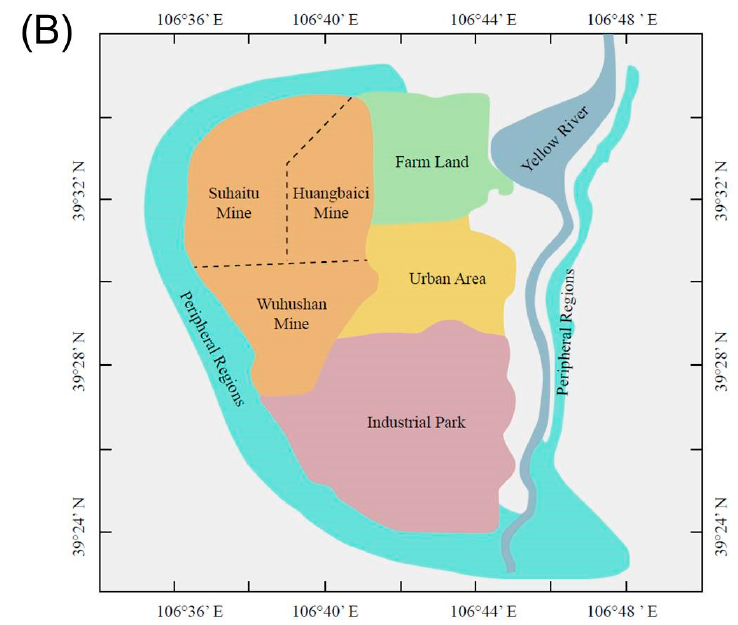
Figure 1. Location of Ordos Basin and the Wuda Coalfield and paleogeographic map of the Late Paleozoic in Northern China (modified after Han and Yang [33]; Liu [34]; and Dai et al. [35]) (1, Wuda Coalfield; 2, Helanshan Coalfield; 3, Hengcheng Coalfield; 4, Weizhou Coalfield; 5, Weibei Coalfield; 6, Hedong Coalfield; and 7, Junger Coalfield) ( A ), and the division of Wuda District, Wuhai City, Inner Mongolia (modified after Cao et al. [37]) ( B ).